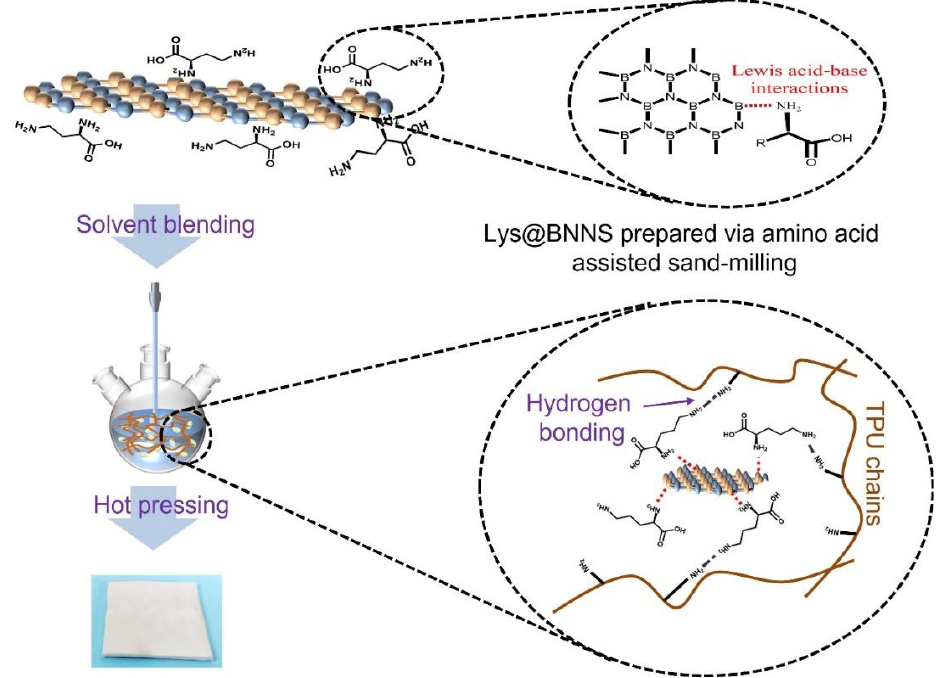
Figure 1. The preparation process of TPU composite